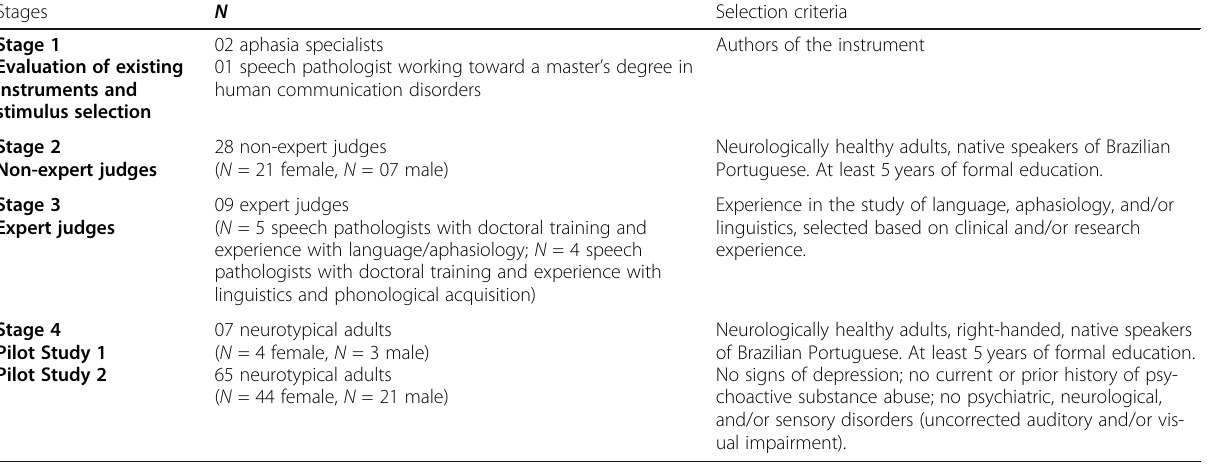
Table 1 Description and selection criteria for participants in each stage of the adaptation and validation of the Brief MTL-BR Stages